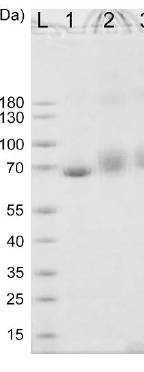
Figure 2. SDS-polyacrylamide gel electrophoresis of BSA. Lane L is the protein ladder. Lanes 1–3 represent images of BSA, SMCC-treated BSA, and BSA-Apt, respectively.